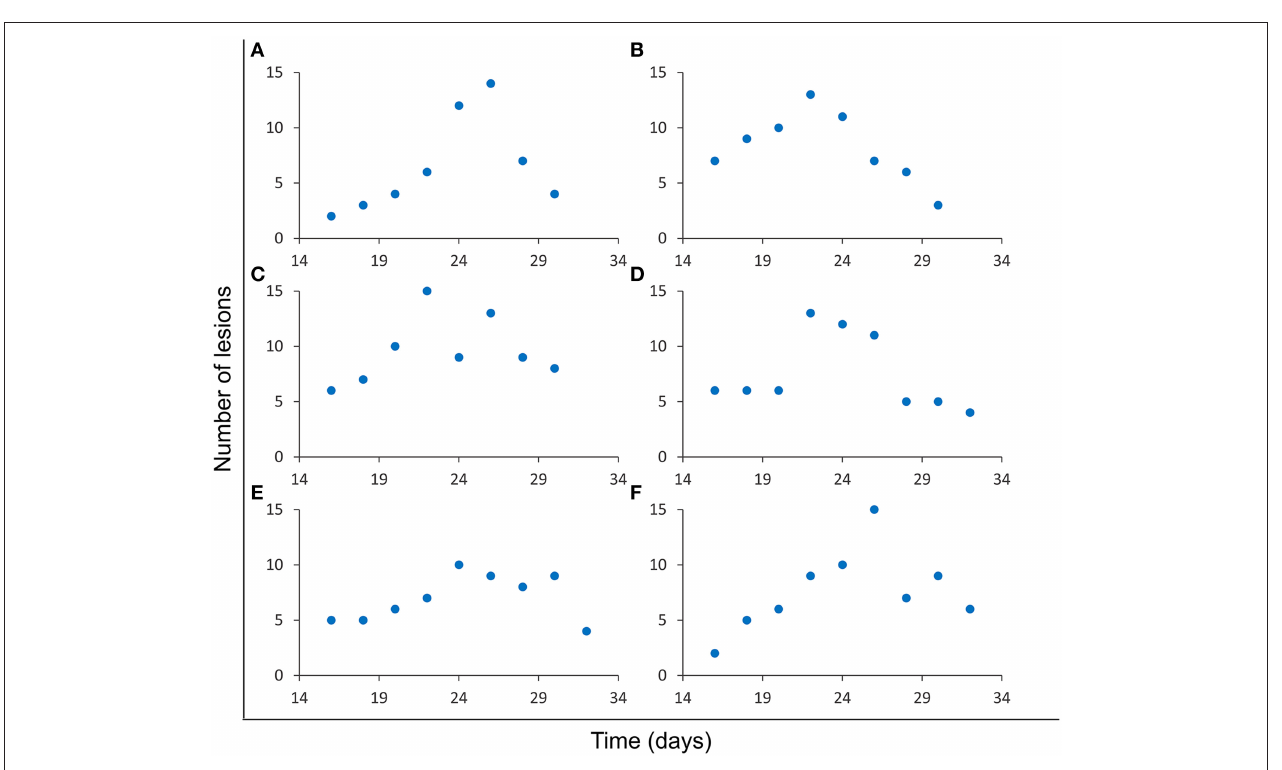
FIGURE 3 | Evolution of the number of lesions in a single slide. Results from six independent simulations (A–F) obtained using the parameters for series A (Table 1) . Different fluctuation patterns can be observed for this